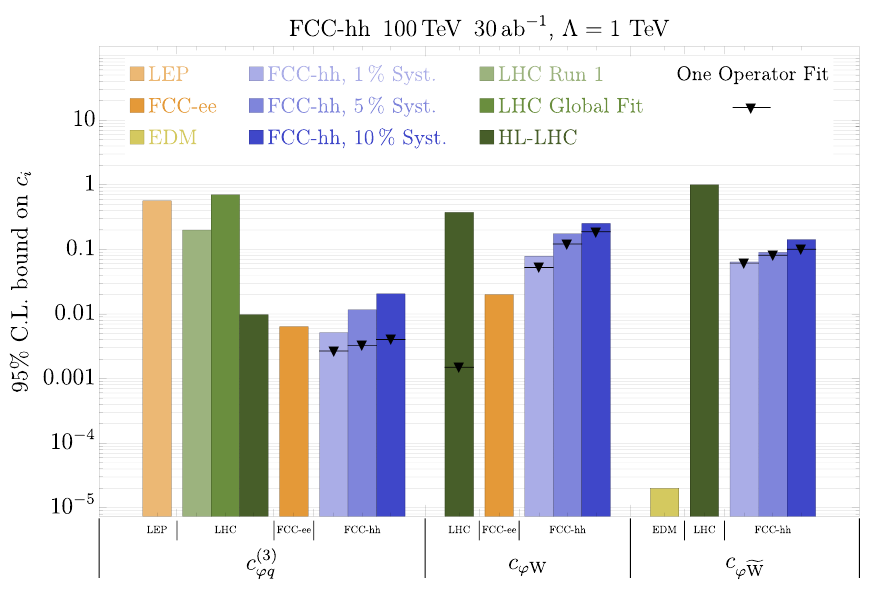
Figure 7 . 95% C.L bounds on c (3) ’q , c ’ w and c . In blue our bounds from Wh ! ‘(cid:23)(cid:13)(cid:13) for FCC-hh ’ e w 1 for di(cid:11)erent systematics for a three operator (cid:12)t. The black lines with a triangle on with 30 ab (cid:0) top represent the bound for a one operator (cid:12)t instead. In light orange the current LEP [12] bound for c (3) ’q . In lighter and darker green for c (3) ’q , the LHC and HL-LHC bounds using leptonic WZ (5% syst) [12]. In medium green the current bounds on c (3) ’q from a global (cid:12)t [62]. In darker green also, the HL-LHC projections for c ’ w [21, 38] (obtained from a global (cid:12)t) and c [60, 61] (obtained ’ e w from CP-odd observables in single Higgs production). Assuming no structural cancellations, we show the bound on c ’ w from a one parameter (cid:12)t using (cid:14)(cid:20) (cid:13) in [38, 63] as a triangle on the green bar. In darker orange the FCC-ee bounds from a global (cid:12)t in [21] with the con(cid:12)guration FCC-ee Z/WW/240 GeV/365 GeV. In yellow the EDM bound taken from